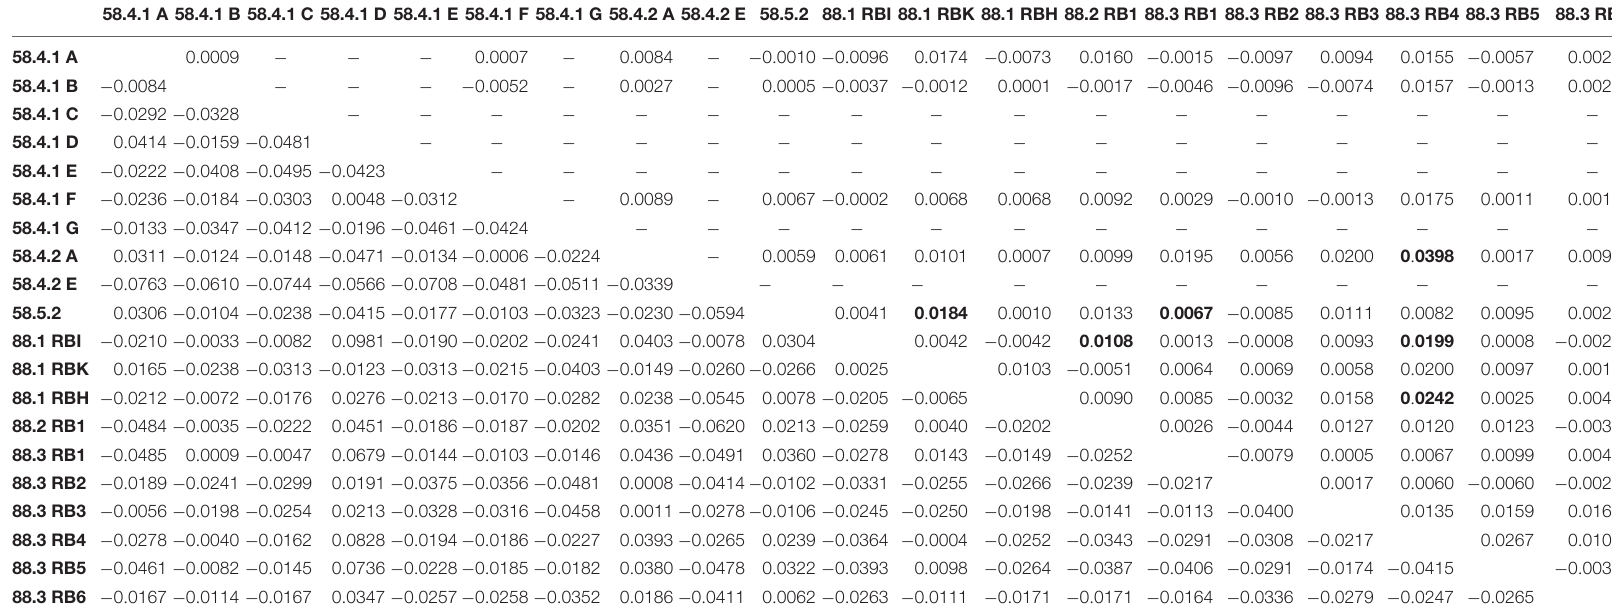
TABLE 3 | Pairwise genetic differentiation ( F ST ) based on mtDNA COI and 16S sequences (below diagonal) and seven microsatellites loci genotypes (above diagonal) for two Subareas 58 and 88 of Dissostichus mawsoni from the Antarctic Ocean.